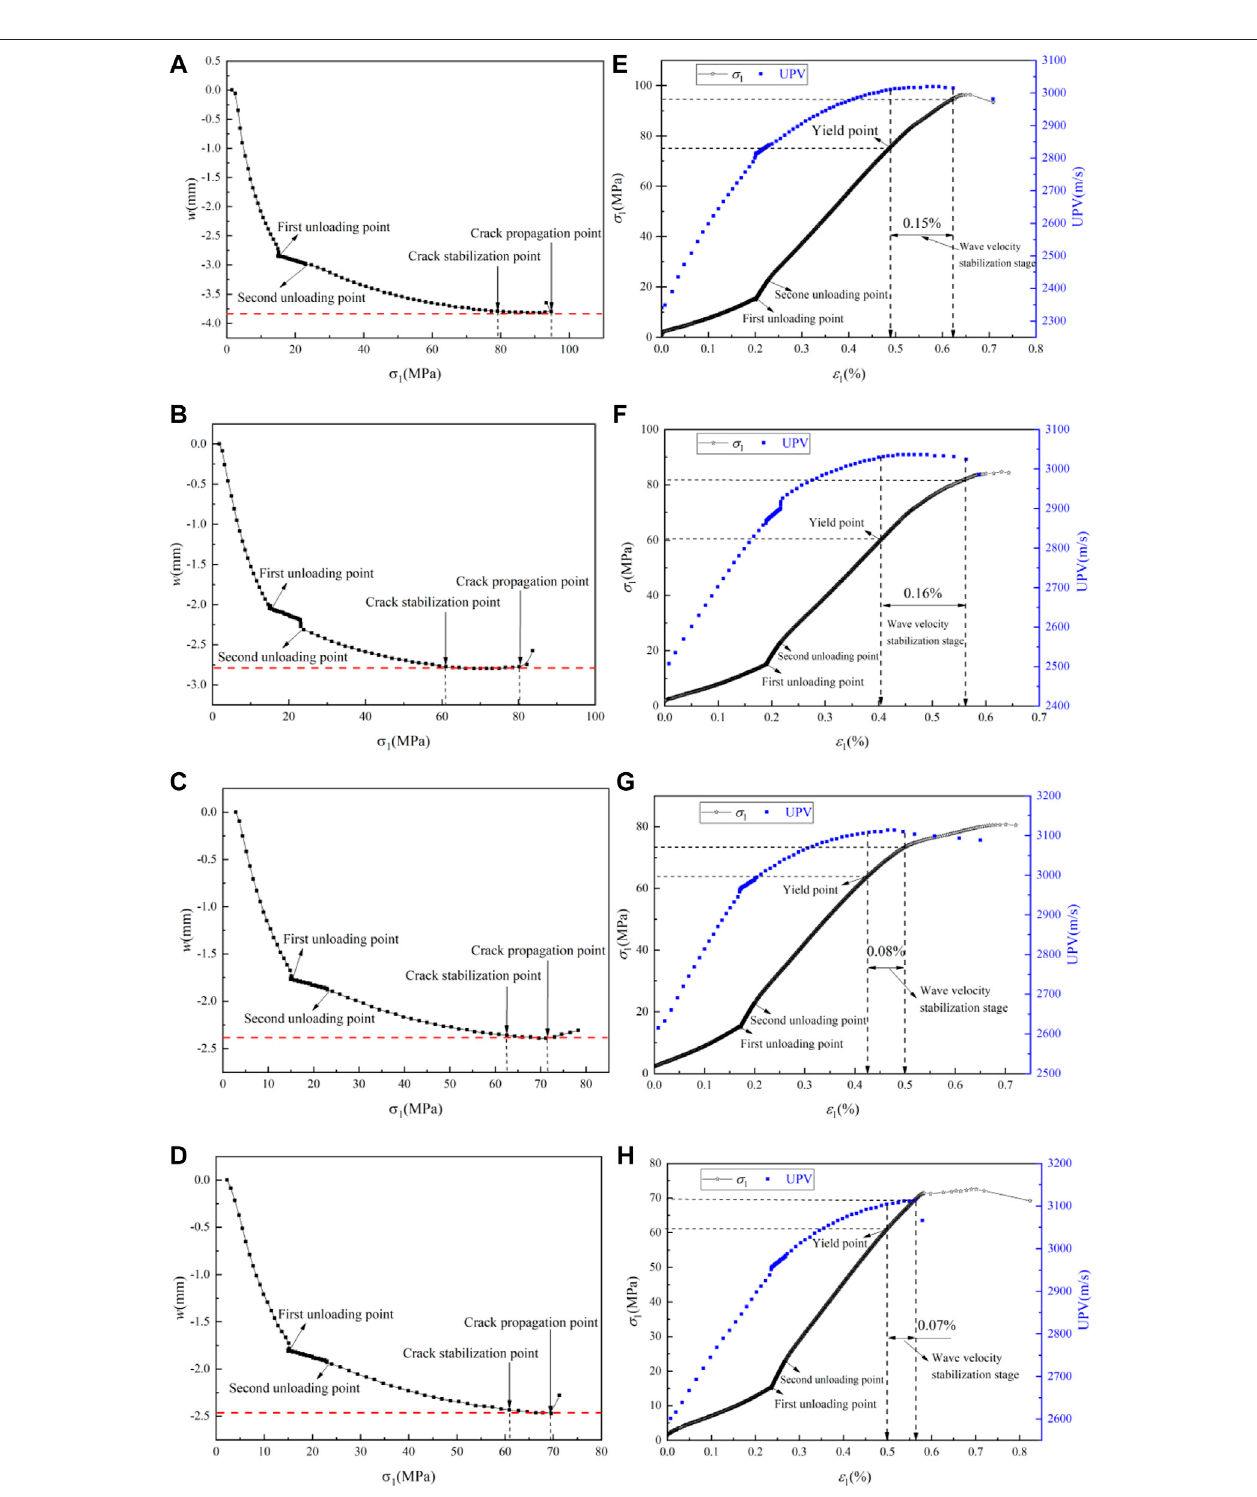
FIGURE 11 | The relationship between axial stress and total crack width (A,B,C,D) , and between wave velocity and axial strain (E,F,G,H) of cracked sandstone specimens with different lengths.